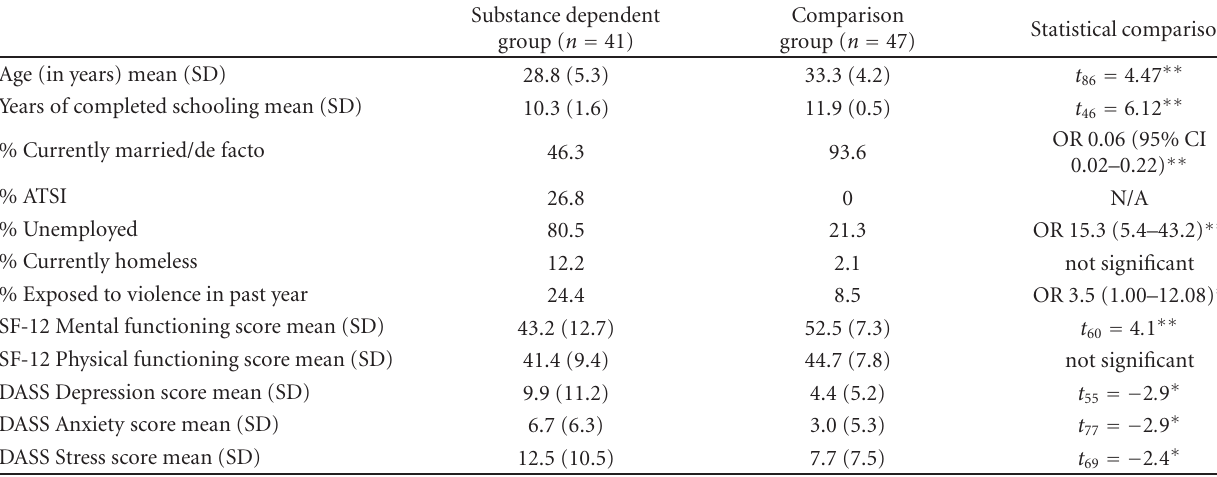
Table 1: Demographic and psychosocial characteristics of pregnant substance dependent women and comparison